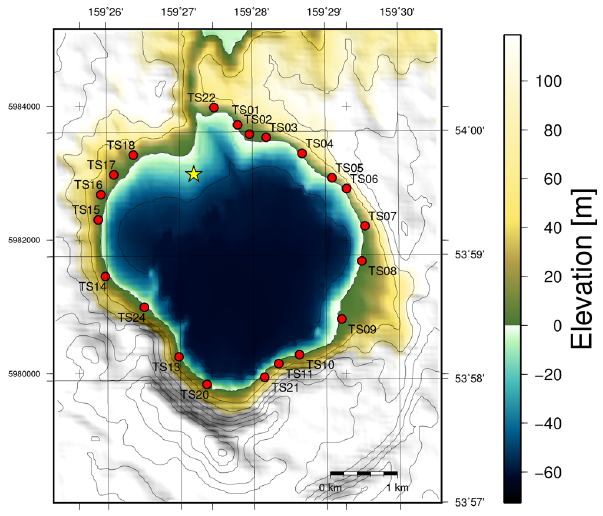
Fig. 1. Pre-eruption bathymetry (negative) and topography (posi- tive) of the Karymskoye lake, Kamchatka, and its surrounding. Con- tour lines with constant contour interval 50m are also depicted. Red points show locations where run-up was measured. The yellow star represents the position of the centre of the new formed crater.